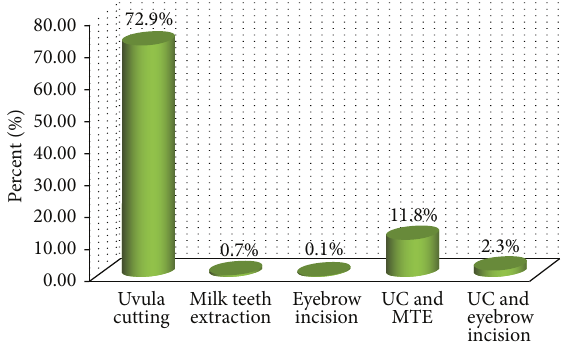
Figure 1: Types of harmful traditional practices among children less than 5 years in Axum Town, North Ethiopia, 2013.